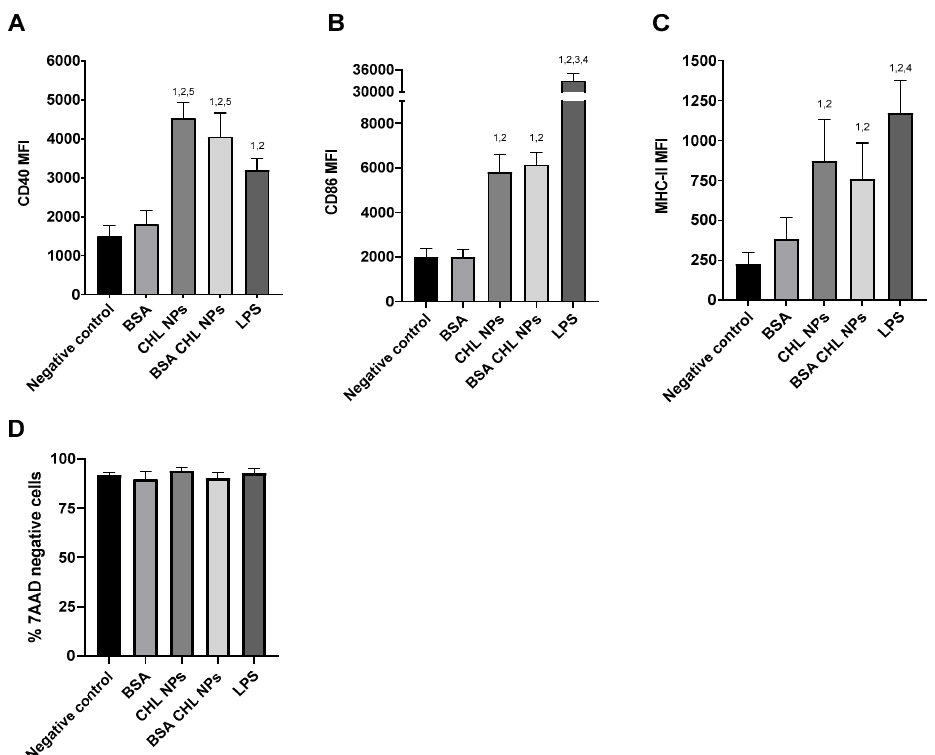
Figure 9. Upregulation of cell surface CD40 ( A ), CD86 ( B ), and MHC-II ( C ) on DCs, and cell viability according to 7AAD staining ( D ), after incubation with BSA incorporated hybrid cationic CHL NPs for 24 h ( n = 6). The indicated groups exhibited significantly greater MFI ( p < 0.05) compared to negative control. ( 1 ), BSA ( 2 ), CHL NPs ( 3 ), BSA CHL NPs ( 4 ), LPS ( 5 ).